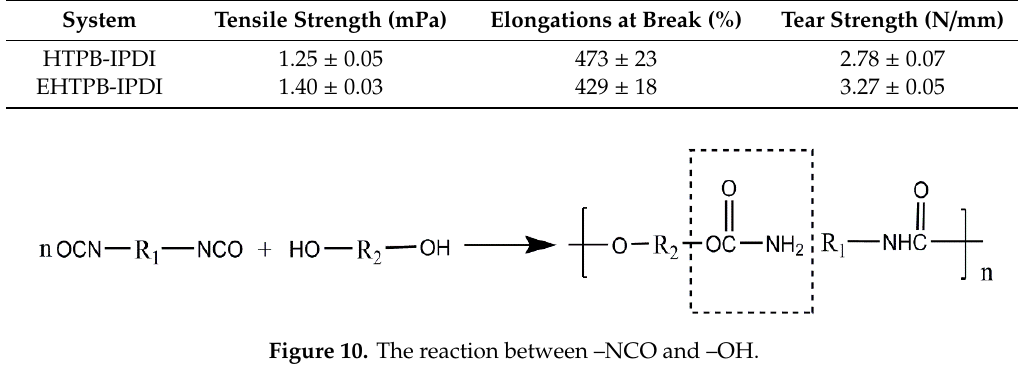
Figure 10. The reaction between –NCO and –OH.